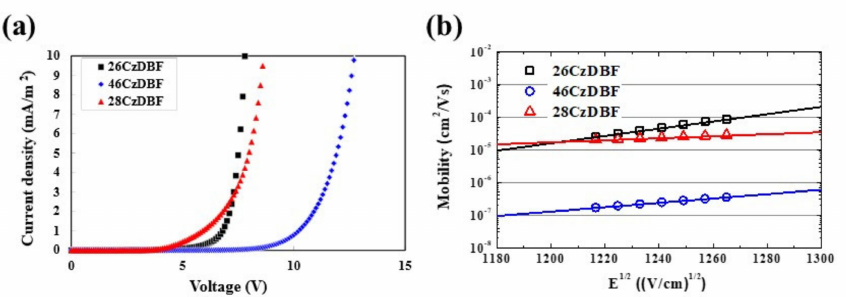
Figure 5. ( a ) Hole-only current density data and ( b ) hole mobility of 26CzDBF, 46CzDBF, and 28CzDBF hole-only